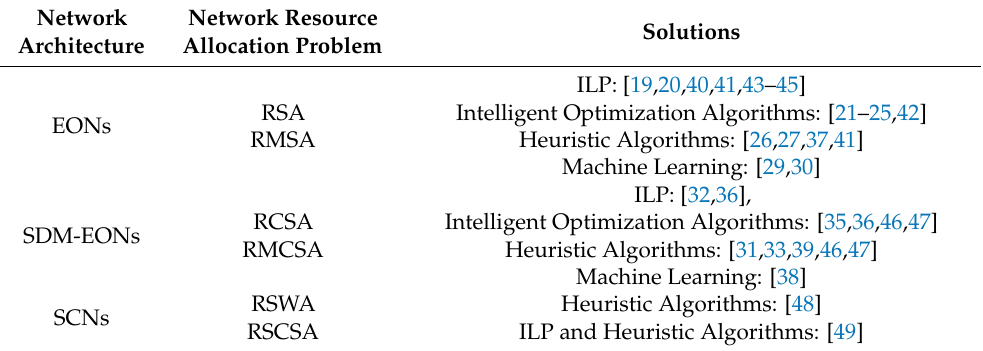
Table 1. Related works on the optical network resource allocation problem. Network